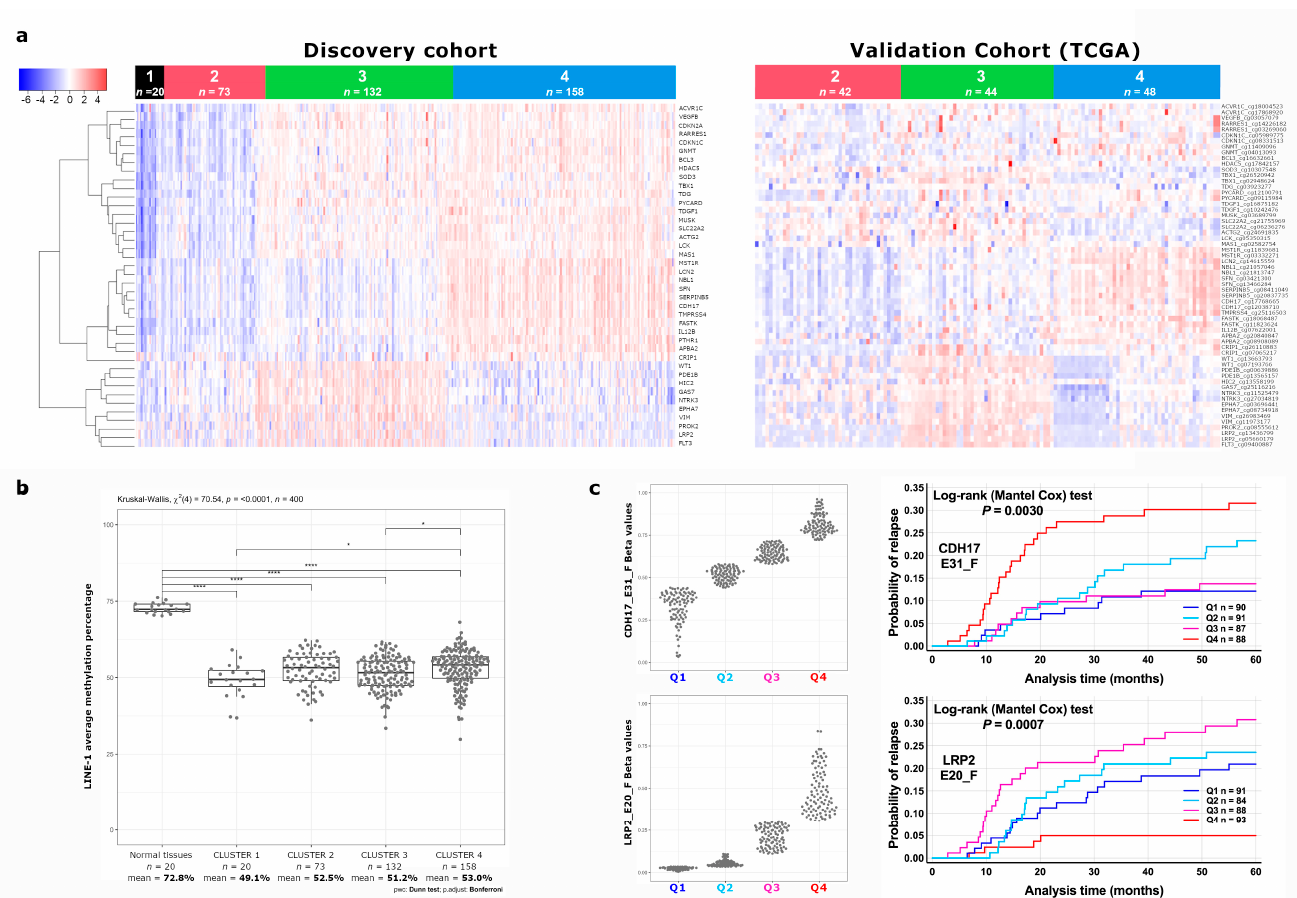
Figure 2. Integrated clinical and DNA methylation analysis identifies a 40 CpG site-based classifier 2 comprising two CpG sites at the CDH17 and LRP2 gene promoters that independently predict risk recurrence in stage II CC. a, Left panel, heatmap showing the four methylation clusters identified from the discovery cohort, using a set of 40 CpG sites (MethylColon II classifier). ( a ) Right panel, heatmap showing the three methylation clusters identified from the validation cohort (TCGA) using a set of 62 equivalent CpG sites. ( b ) Scatter plot of average LINE-1 DNA methylation status (%) in 20 adjacent normal colon tissues and according to methylation clusters of the stage II CC discovery cohort. A boxplot is represented for each group. The result of a Kruskal-Wallis test, indicated in the above panel ( b ), showed a significant difference in methylation percentages between groups ( p -value < 0.0001). A Dunn test was performed, and the significance level of p -values between each group is indicated by asterisks (* p -value ≤ 0.05, **** p -value ≤ 0.0001). Significant differences of LINE-1 methylation percentage between CpG clusters are indicated by an asterisk. An average decrease of 21.4% of DNA methylation was observed between normal tissues and stage II colon tumours (all clusters confounded). ( c ) Left panel, scatter plots of beta values for the CDH17_E31_F (upper left panel) and LRP2_E20_F CpG sites, respectively, (lower left panel), by quartile groups, as indicated. Right panel, cumulative probability of relapse for each of four patient groups defined by methylation levels, according to quartiles, for CDH17_E31_F (upper right panel) and LRP2_E20_F CpG sites (bottom right panel), respectively. The p -value of the log-rank test is indicated in each